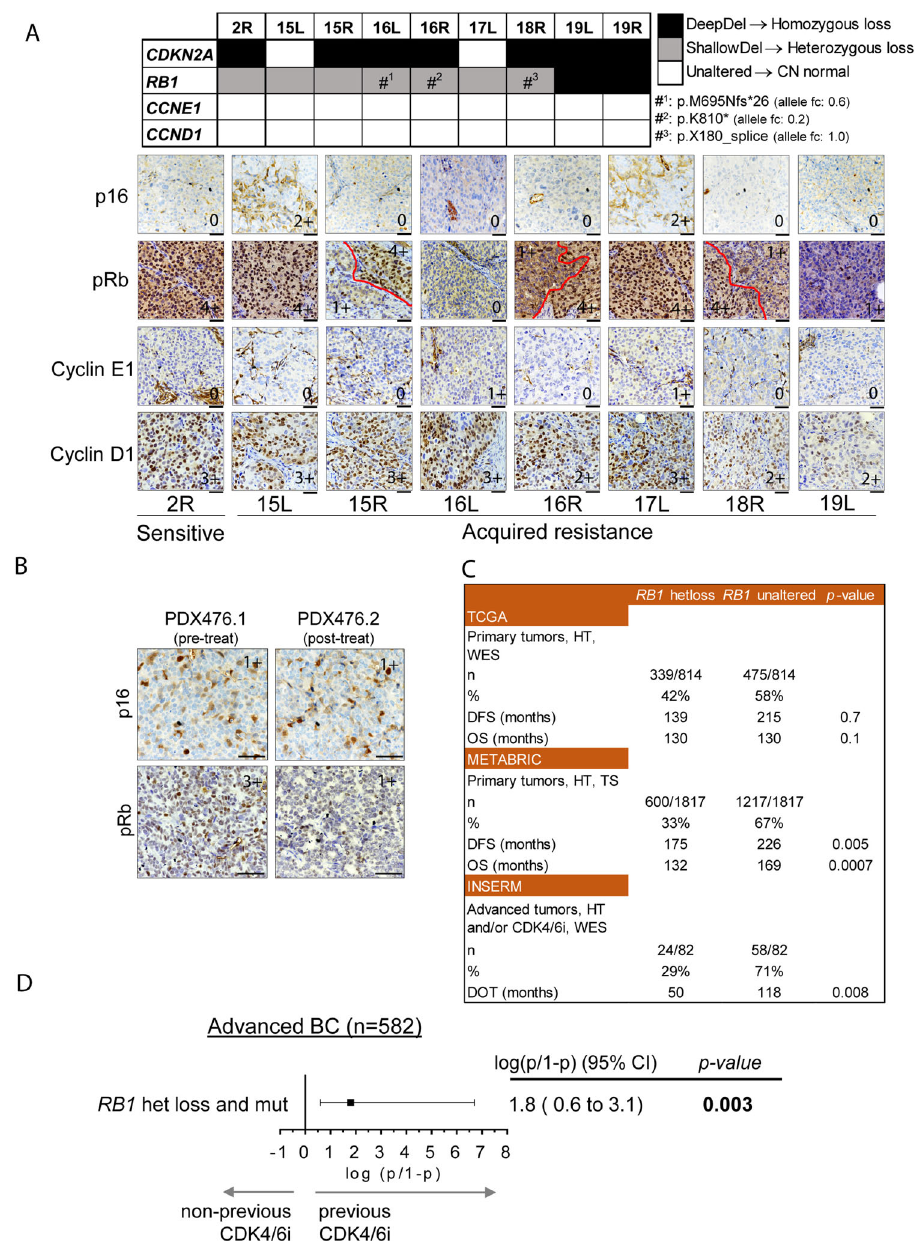
is provided. Scale bar = 100 µ m. C Clinical outcome expressed in months for the indicated clinical endpoint in patients with ER + /HER2 - , RB1 unaltered tumors vs. thoseharboringtumorswith RB1 heterozygousloss.Dataandstatisticalanalysis were extracted from the cBioportal. HT hormone therapy, WES whole-exome sequencing, TS targeted-sequencing, n number of patients, DFS disease-free survival, OS overall survival, DOT days of treatment. D Association between RB1 double hit alterations (concomitant mutation and deletion) and prior exposure to CDK4/6 inhibitors in metastatic BC patients ( n =582 tumors). Black square represent the logit value. Multivariable logistic regression two-tailed unad- justed p -value and the 95% con fi dence intervals (CI; horizontal segment repre- sents) for the test are shown. Source data are provided as a Source Data fi